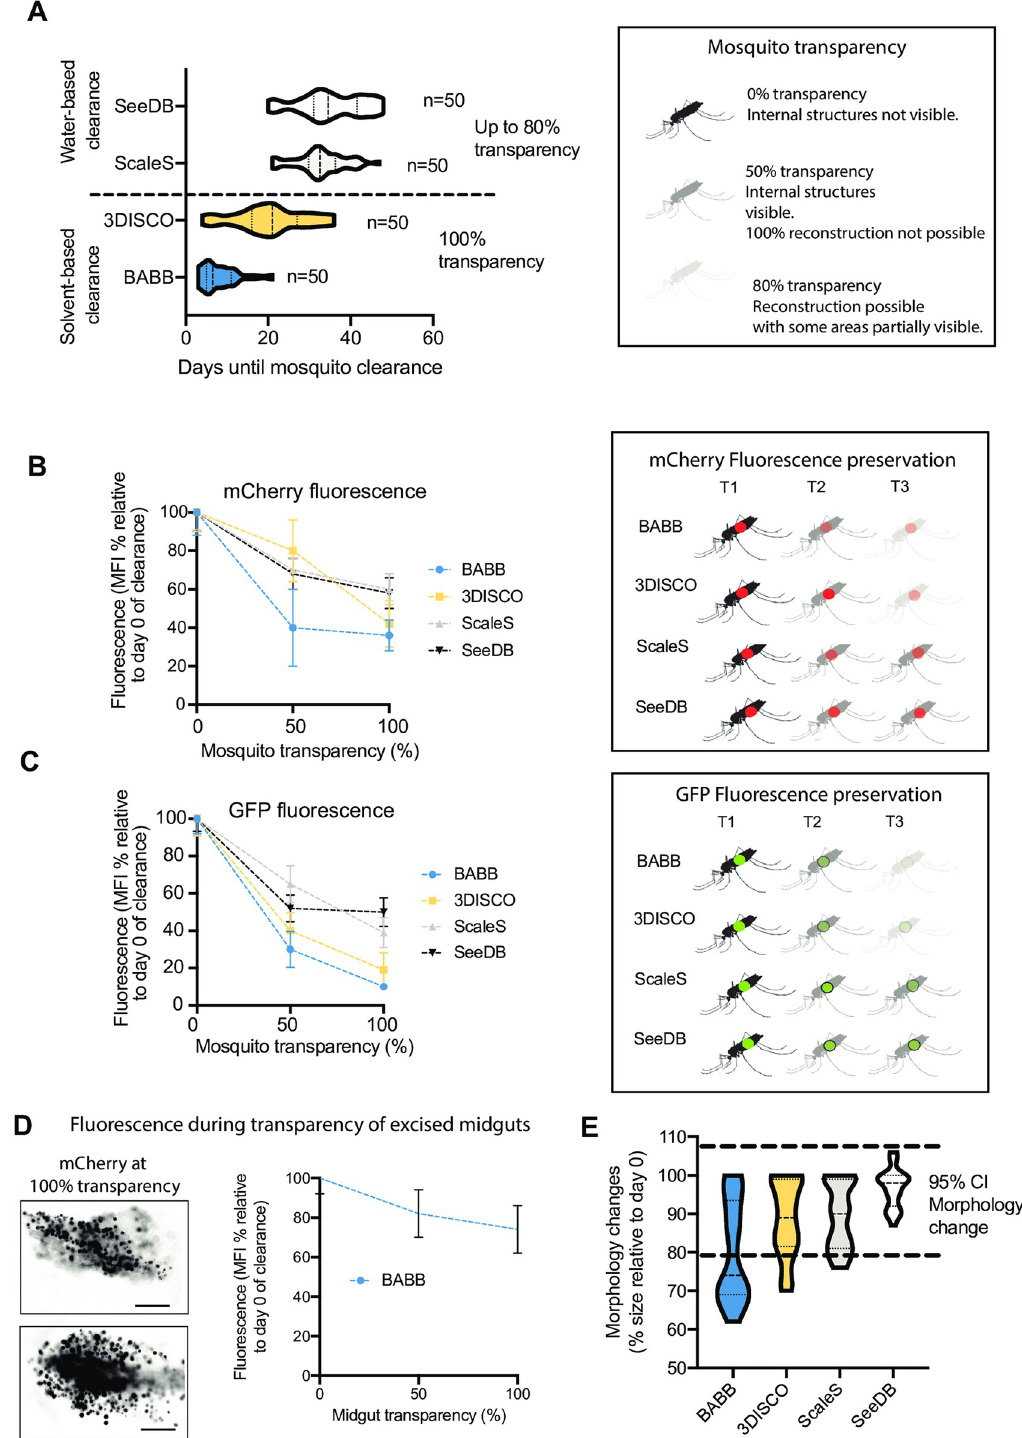
Fig 2. Quantitative and semi-quantitative assessment of tissue clearance methods as applied to A . stephensi mosquitoes. A) Determination of time of clearance for achievement of transparency of Anopheles mosquitoes. For each method, 50 mosquitoes were embedded in ultrapure low melting temperature agarose gel, and processed as required for SeeDB, Sca l eS, 3DISCO and BABB clearance. Mosquitoes were imaged by confocal microscopy, and 100% transparency determined as the possibility to image through the full sample at a high level of detail and without significant light scattering. Two-way ANOVA test between